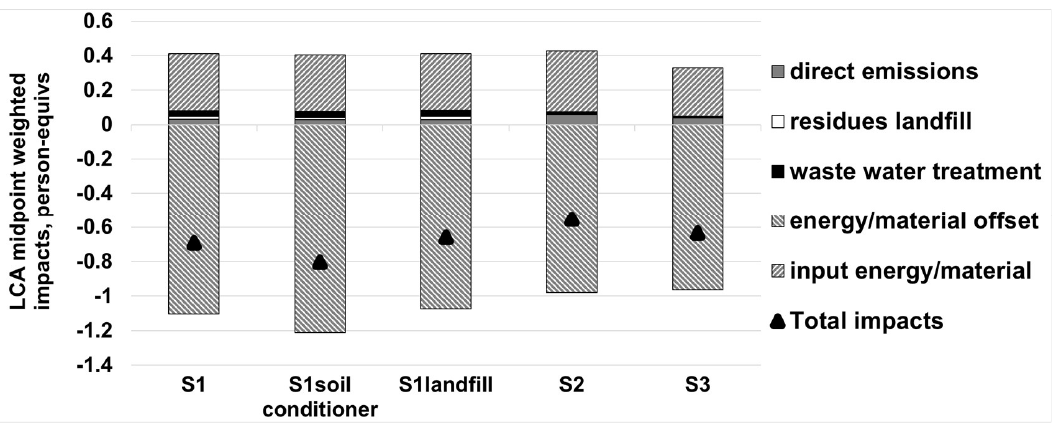
Figure 5. Normalized environmental impacts of the considered